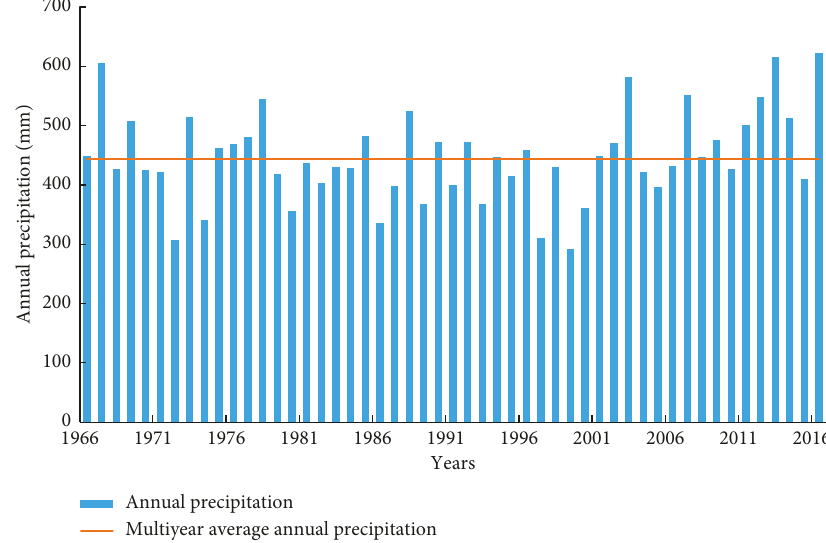
Figure 3: Time series of annual precipitation in the HLR from 1966 to